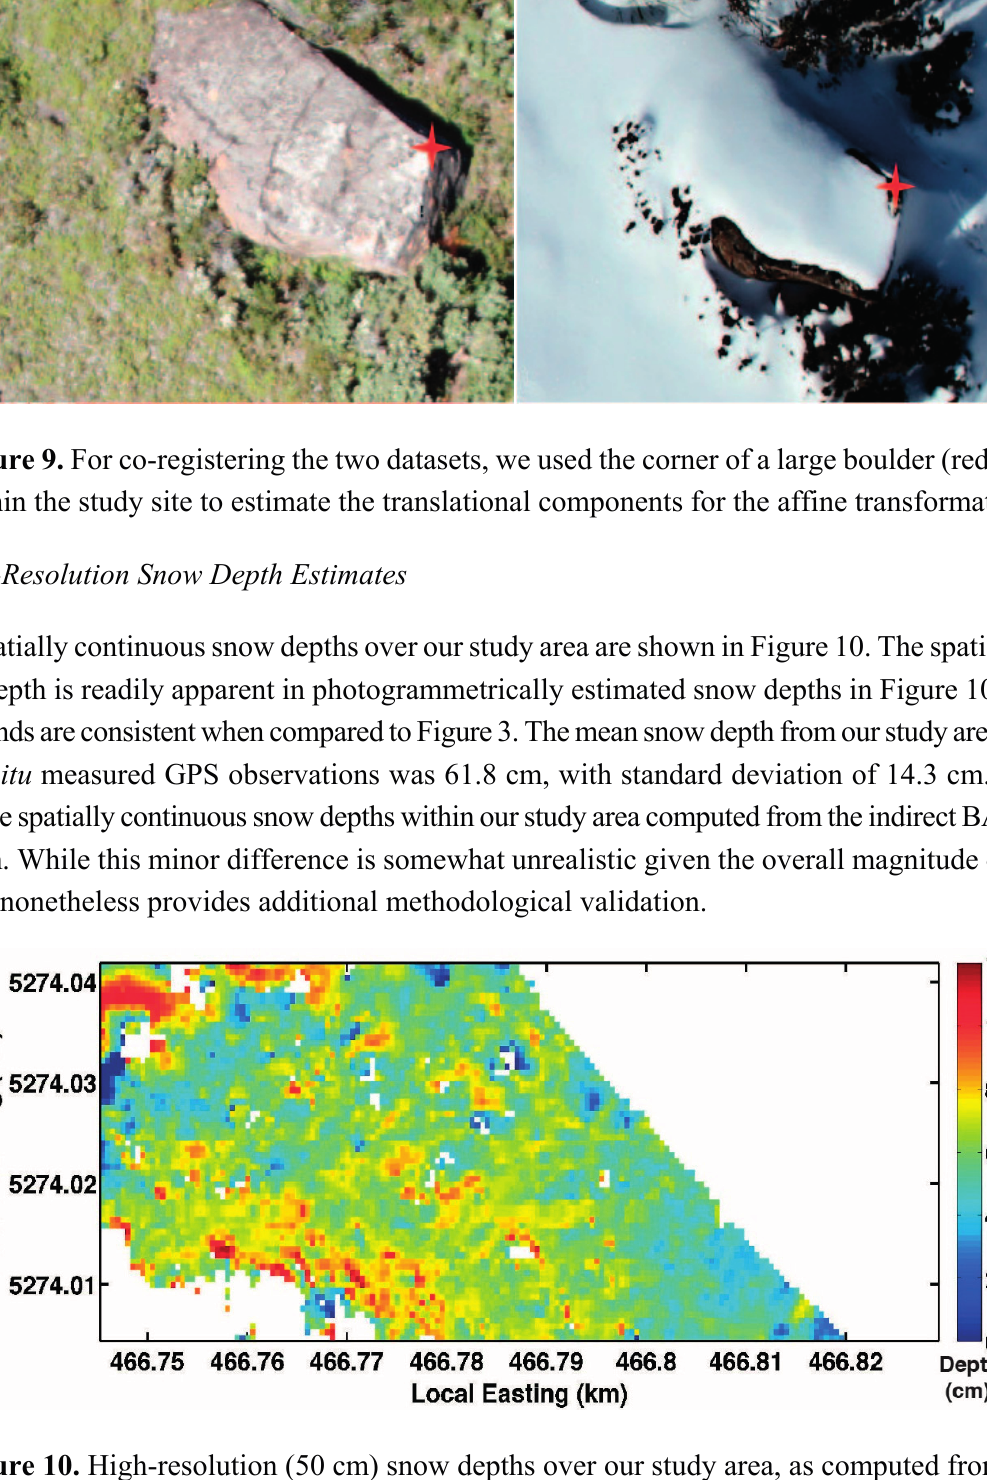
Figure 10. High-resolution (50 cm) snow depths over our study area, as computed from the differenced point cloud measurements. Units of depth are in